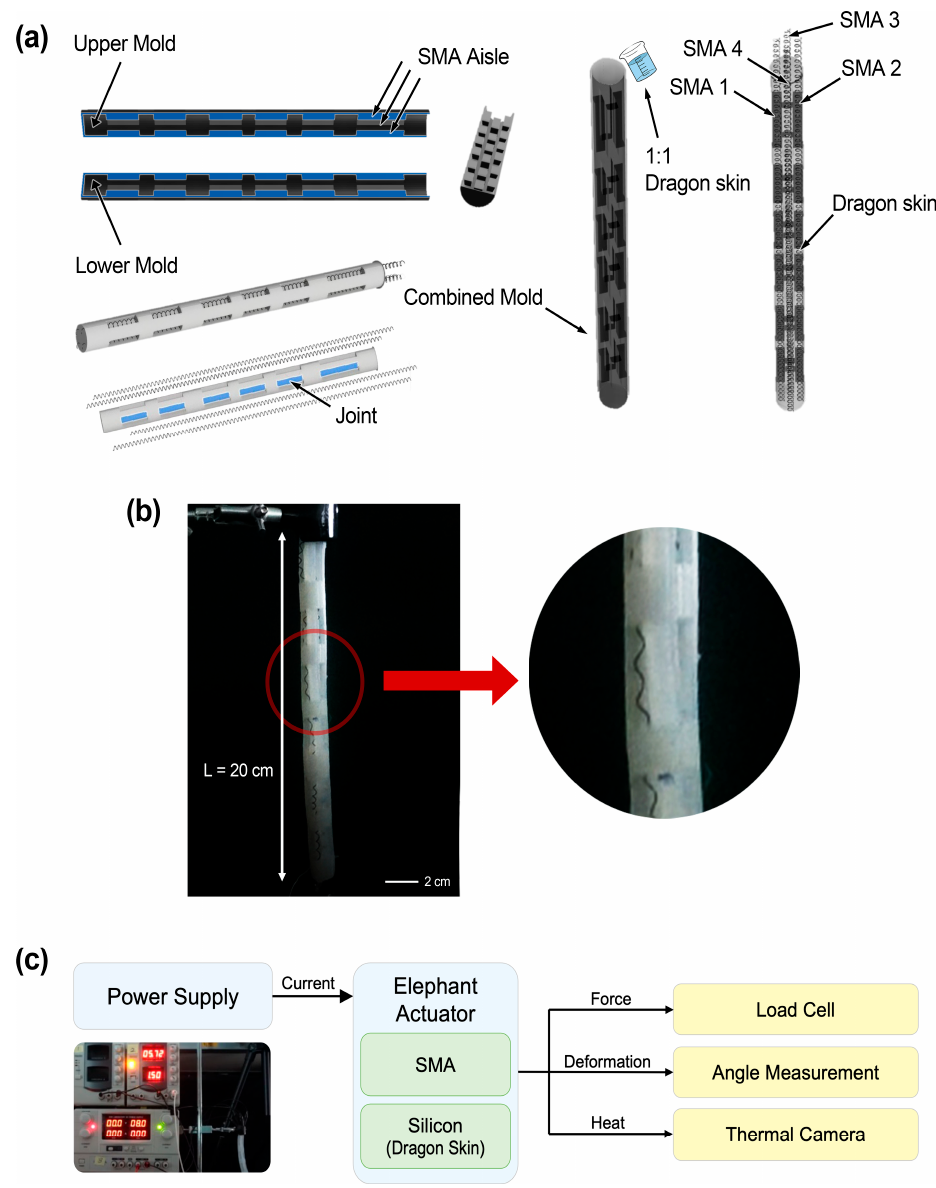
Figure 2. ( a ) Fabrication of an elephant trunk actuators. ( b ) Shape of an elephant trunk actuator. ( c )